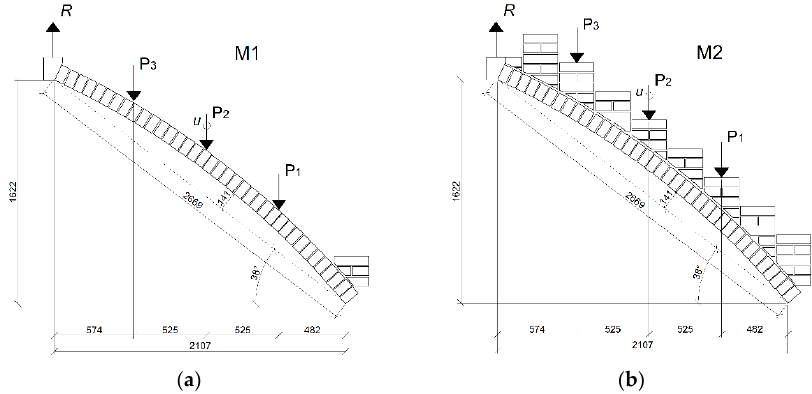
Figure 9. Laboratory models of stair flights (dimensions in mm): model M1—without treads ( a ); model M2—with treads ( b ). P 1 –P 3 —force application points; R —force from the arch registered with a force gauge; u —vertical displacement in the middle of the arch span. model M2—with treads ( b ). P 1 –P 3 —force application points; R—force from the arch registered with a force gauge; u—vertical displacement in the middle of the arch